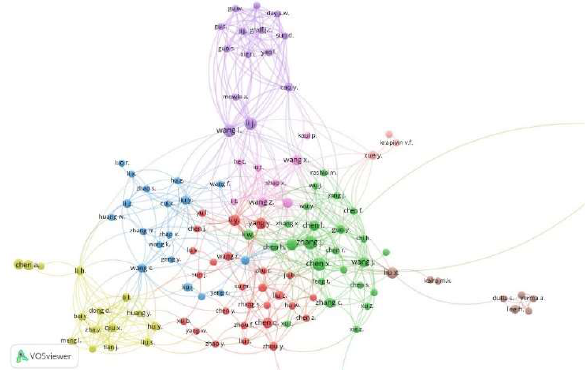
Figure 11. Citation and analysis of co-authors with strong links.